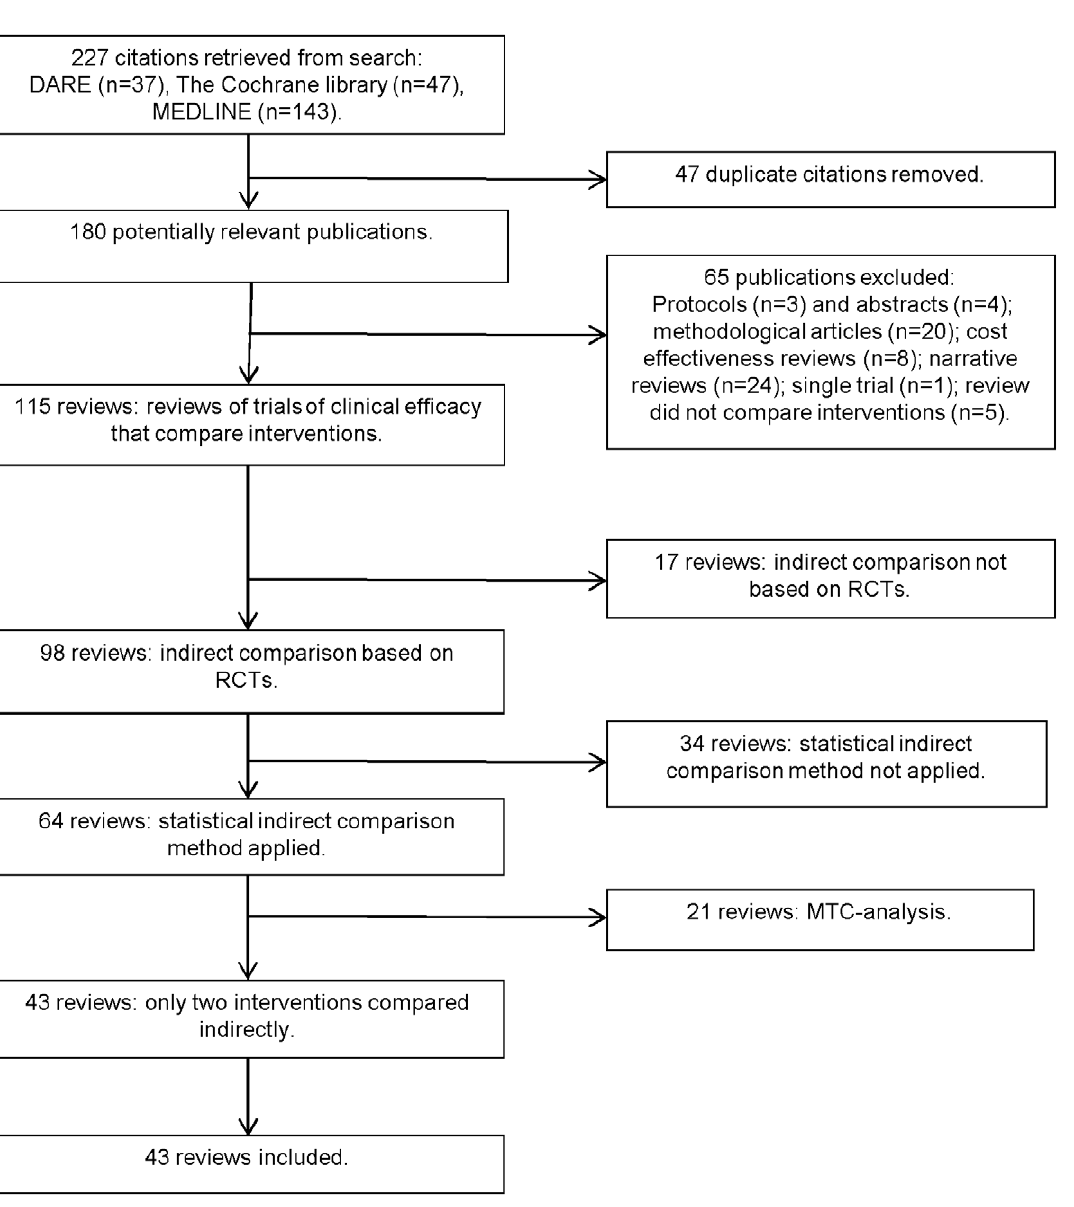
Figure 1. Selection process for reviews. Abbreviations: RCTs (randomised controlled trials).